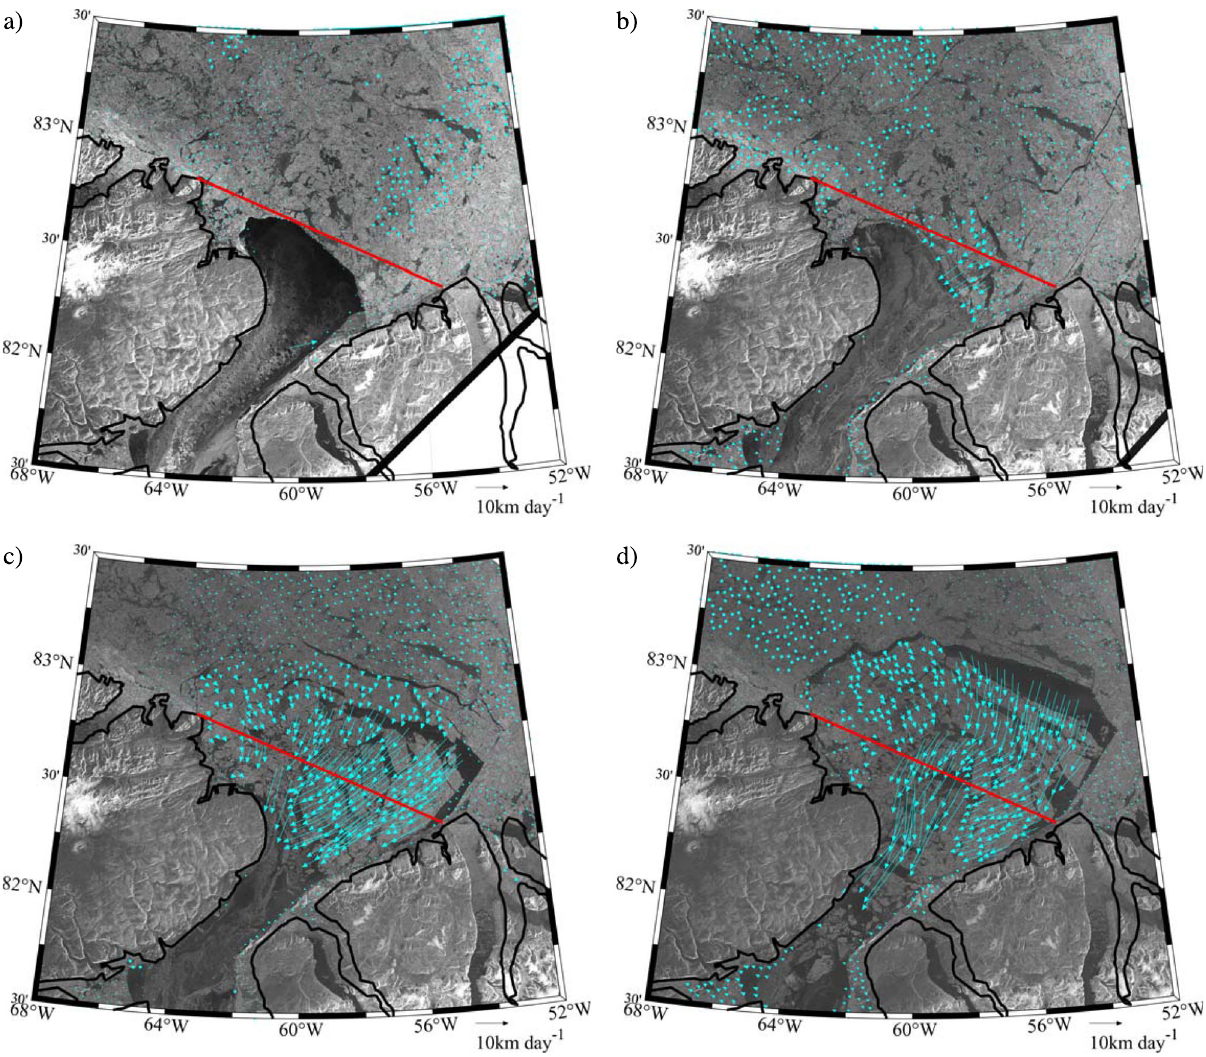
Fig. 2 Collapse of the Lincoln Sea Ice Arch during May 2017. Sentinel-1 SAR satellite images and derived sea ice motion vectors (km day -1 ) on: a May 8, 2017 at 12:55 GMT; b May 10, 2017 at 12:40 GMT; c May 12, 2017 at 12:32 GMT; and d May 14, 2017 at 12:08 GMT. The southern Lincoln Sea fl ux gate used to calculate the ice area fl ux is shown in red.